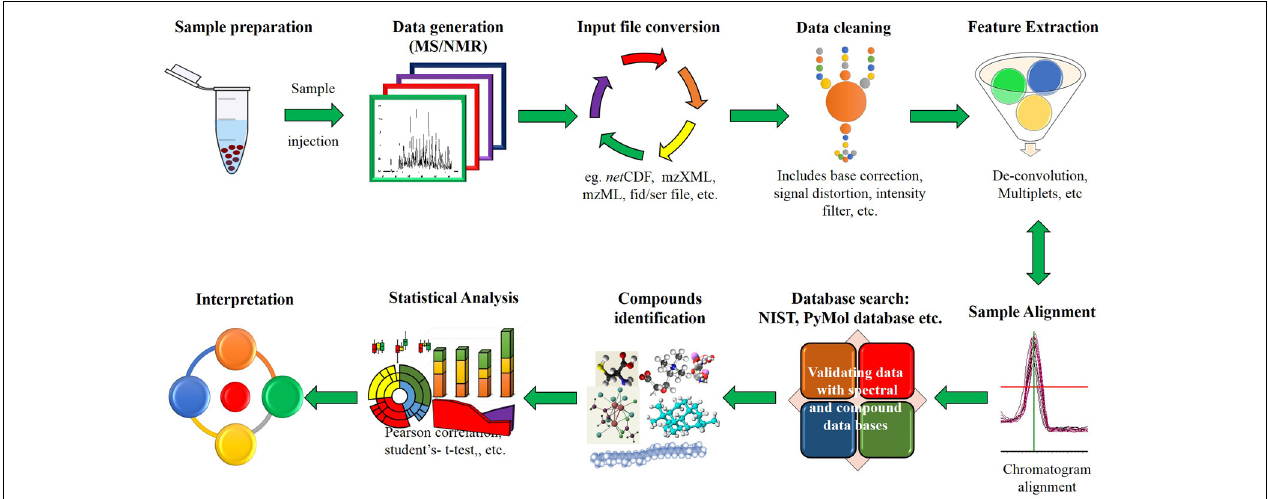
FIGURE 1 | Schematic representation of high throughput data analysis process. A set of raw data files is read after file conversion to desired formats. Data cleaning involves cleaning input file to remove false positives through noise reduction and background correction. Feature extraction is used to differentiate individual peaks from overlapped or closely aligned ones. Additionally, compounds can be identified by analyzing spectra and chemical compound structures available in the metabolomics library or